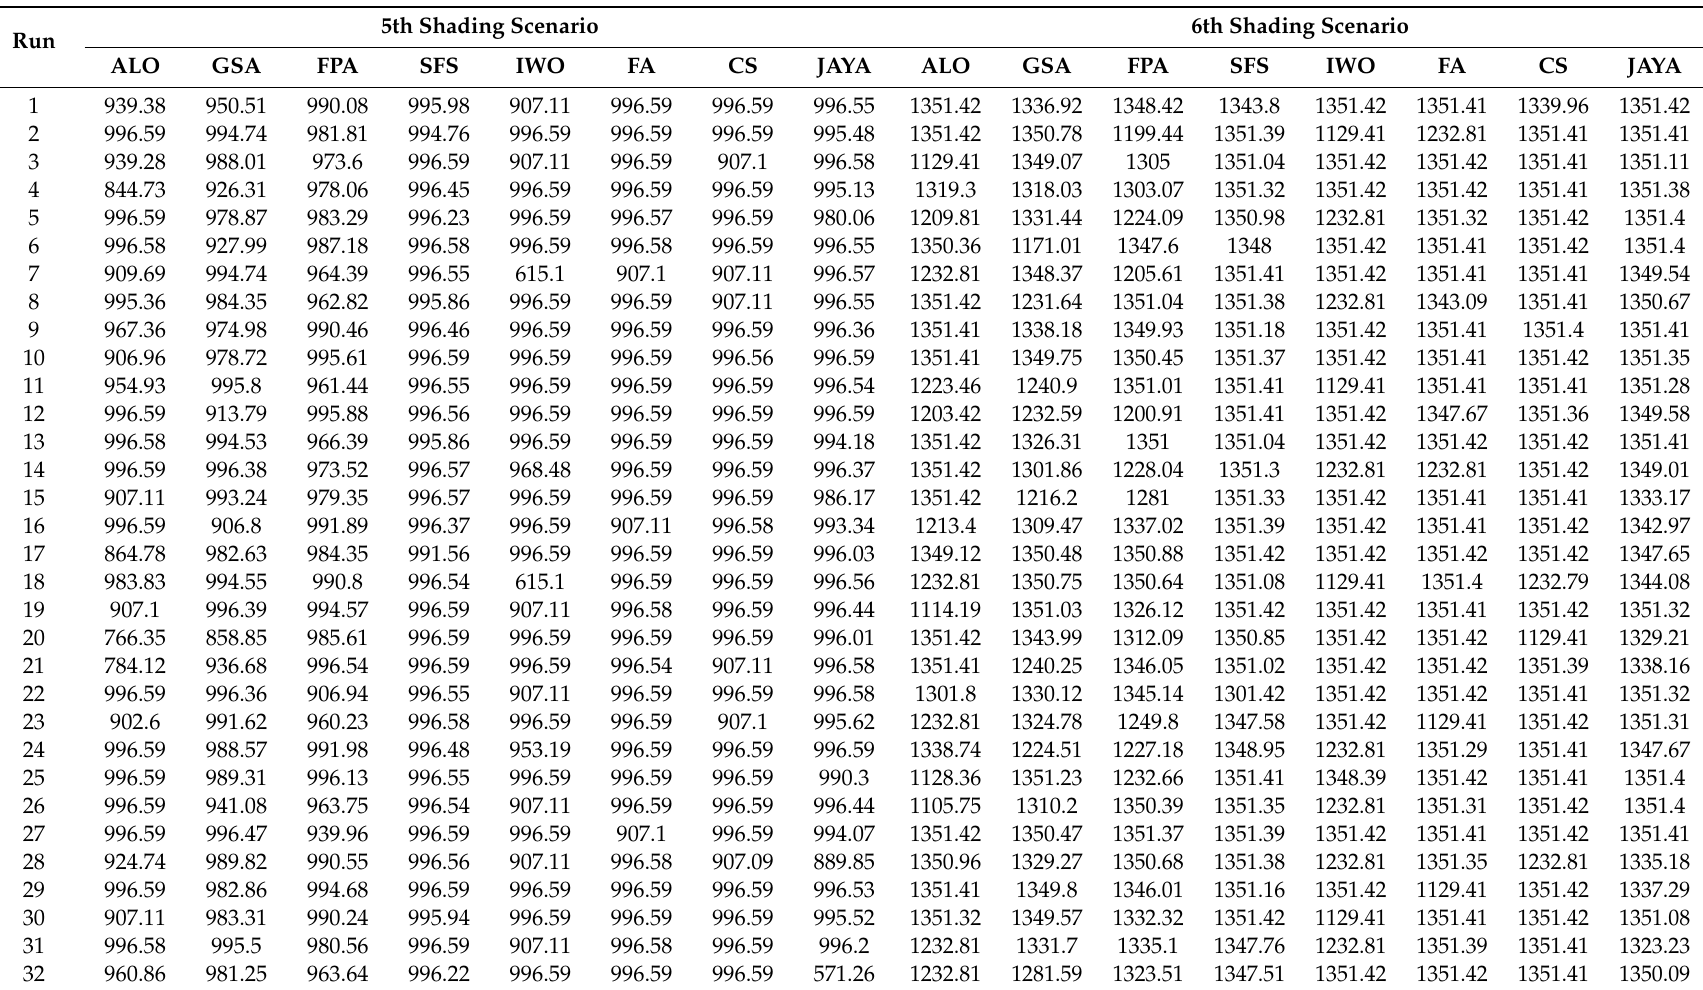
Table A3. The detailed performance of each optimizer for the 5th and 6th shading